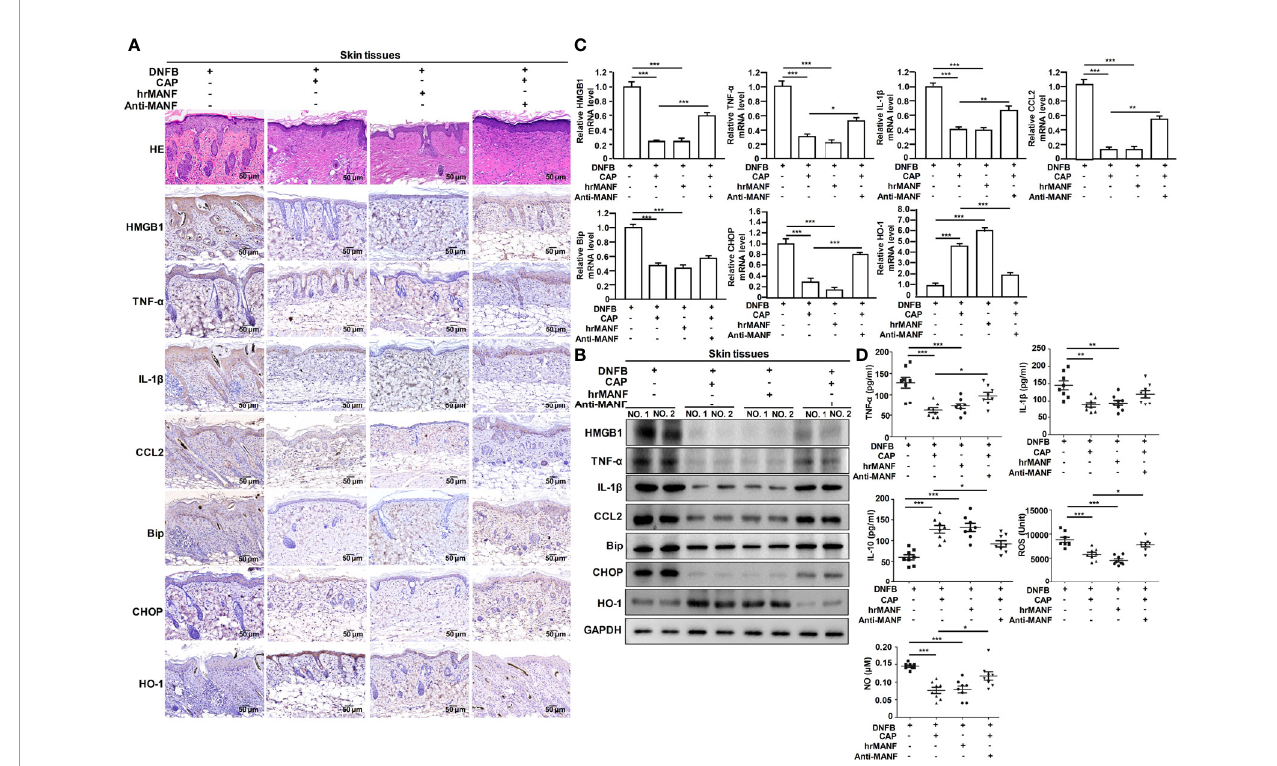
FIGURE 3 | CAP relieved DNFB-induced skin in fl ammatory injury, ER stress and oxidative stress via promoting MANF expression. DNFB-induced AD mice model was constructed, followed by CAP treatment, hrMANF treatment and MANF antibody treatment, n=8. Skin tissues (n=5) were used for HE and immunohistochemical staining of HMGB1, TNF- a , IL-1 b , CCL2, Bip, CHOP and HO-1 (A) , as well as western blot (B) and RT-qPCR (C) of the indicated proteins. GAPDH serves as control for normalization. (D) Serum samples (n=8) were used for ELISA of TNF- a , IL-1 b , IL-10, NO and ROS. Data are expressed as mean ± SEM. *p < 0.05, **p < 0.01, *** p <